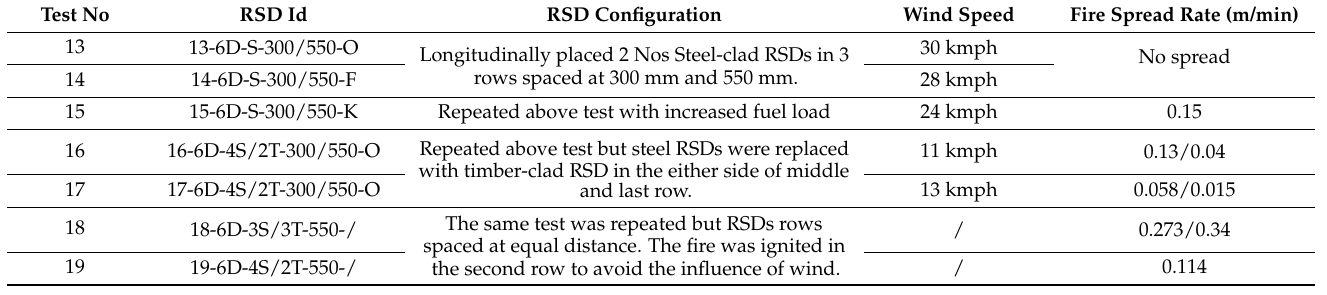
Table 10. Testing matrix of six RSD experiment.